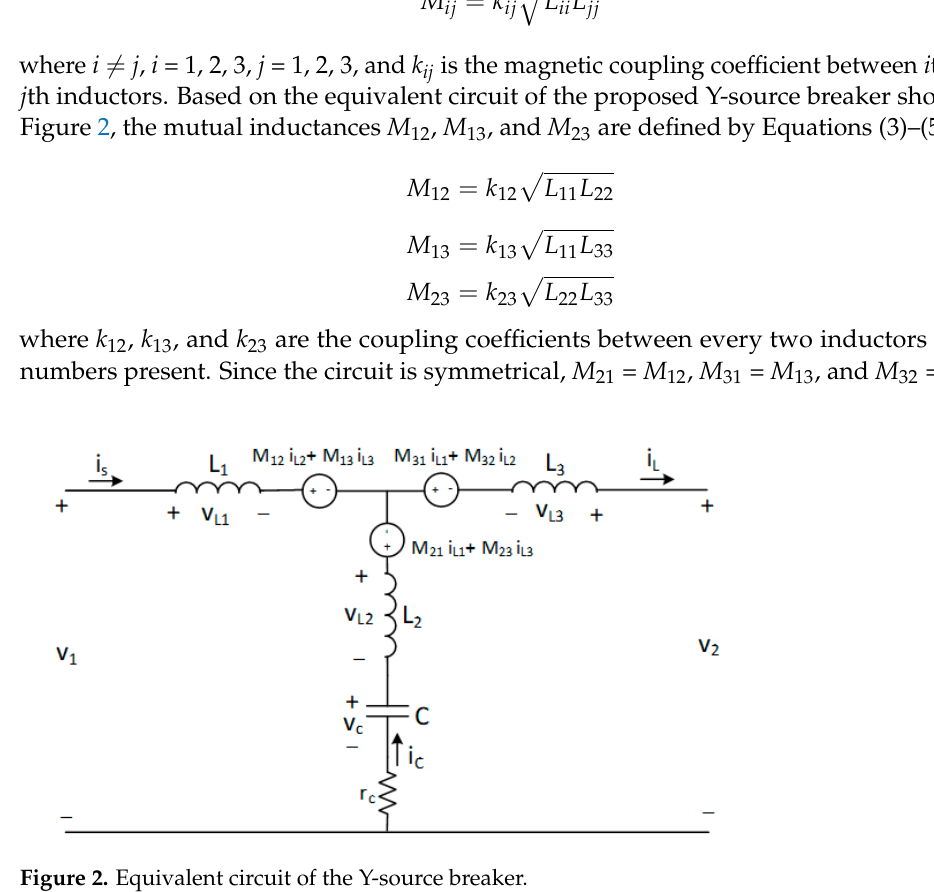
Figure 2. Equivalent circuit of the Y-source breaker.